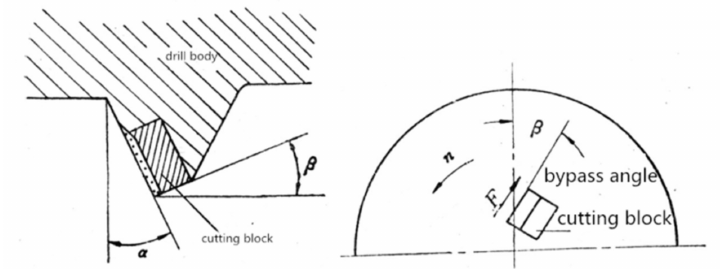
Figure 5. The negative antecedent Angle and bypass Angle of the composite chip bit.